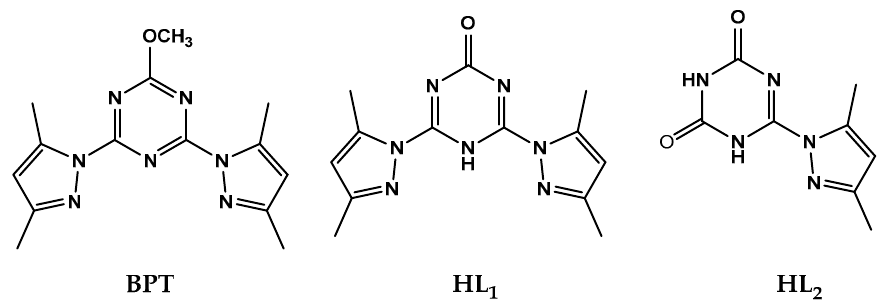
Figure 1. Structure of the studied ligand (BPT) and its hydrolyzed ligands HL 1 and HL 2 .